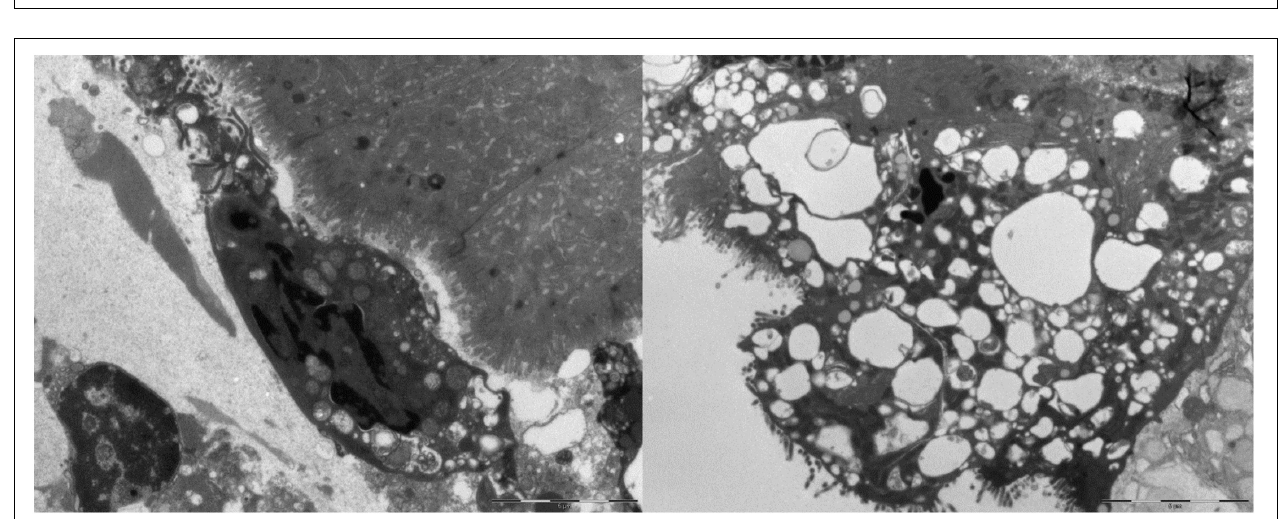
FIGURE 2 | Ultrastructural image of ileal (left) and colonic (right) mucosa.